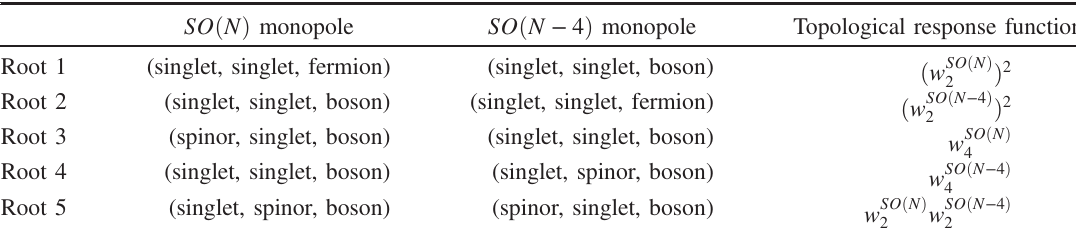
TABLE V. Properties of the SO ð N Þ and SO ð N − 4 Þ monopoles of the root states for odd N . The SO ð N Þ monopole breaks the I ð N Þ symmetry to SO ð 2 Þ × SO ð N − 2 Þ × SO ð N − 4 Þ , and it always has no fractional charge under the SO ð 2 Þ . Its three corresponding entries represent its representation under the SO ð N − 2 Þ , its representation under the SO ð N − 4 Þ , and its statistics, respectively. The SO ð N − 4 Þ monopole breaks the I ð N Þ symmetry to SO ð N Þ × SO ð N − 6 Þ × SO ð 2 Þ , and it always has no charge under the SO ð 2 Þ . Its three corresponding entries represent its representation under the SO ð N Þ , its representation under the SO ð N − 6 Þ , and its statistics, respectively. The last column lists the topological response function corresponding to these root